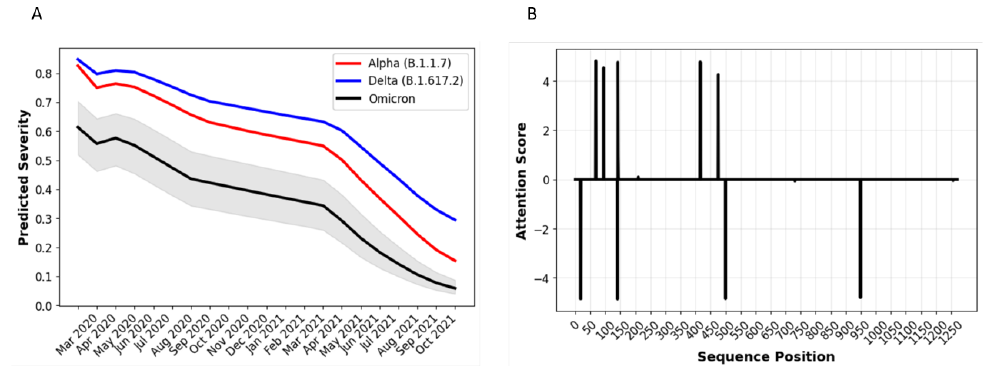
Figure 8. ( A ) Model prediction of the average time-dependent disease severity, assuming a 50- year-old male patient, for samples with known sequences from Beta, Delta, and Omicron lineages. Omicron is predicted to have, on average, a 35–40% reduced risk of severe disease as compared to Delta, and to have reduced risk relative to Beta as well. ( B ) Differential attention plot showing the spike protein sequence positions that have the greatest difference in attention score between most commonly found Delta and Omicron sequences. Sites with a greatest positive attention difference are 69–70 (where Omicron has a deletion also present in Alpha but not Delta), 95 (the most common Omicron sequence type, shown here, lacks Delta’s T95I mutation), 143–144 (Omicron has a deletion), 211 (Omicron has a deletion), 417 (Delta lacks the K417N found in many but not all Delta lineages), and 477 (Omicron lacks S477N). Sites with the greatest negative attention difference are 19 (T19R found in some but not all Delta sequences), 142 (Omicron lacks Delta’s D142G), 501 (N501Y also found in Alpha) and 950 (Omicron lacks